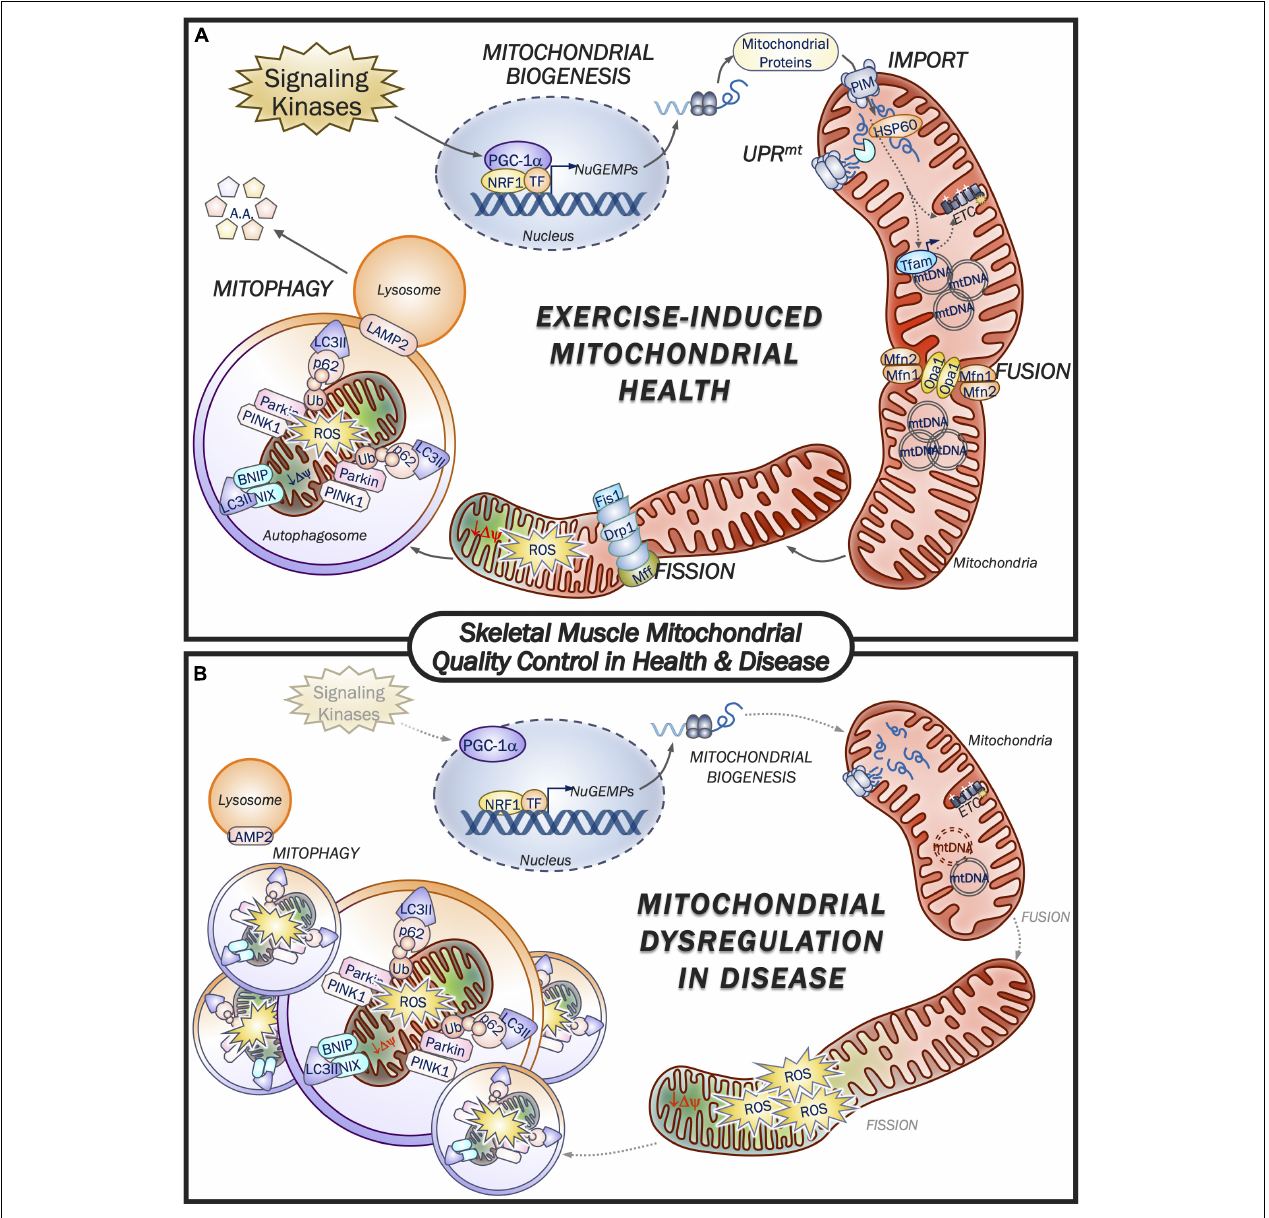
FIGURE 1 | Skeletal muscle mitochondrial quality control in health and disease. (A) Exercise is a potent promotor of mitochondrial health by eliciting increases in mitochondrial quality control machinery. Upstream signaling kinases respond to muscle contractile activity leading to activation of PGC-1 α and augmented transcription of nuclear genes encoding mitochondrial proteins (NuGEMPs). Newly translated mitochondrial-targeted proteins are then transported into the mitochondrion via the protein import machinery (PIM) and are subsequently met by resident chaperones and proteases to facilitate their incorporation within the organelle. The UPRmt is responsible for regulating the expression of mitochondrial chaperones and proteases in the presence of a stress stimulus such as exercise. As mitochondrial volume within the myofiber expands, fusion machinery adjoins neighboring organelles’ inner and outer membranes to facilitate transfer of metabolites, mtDNA, etc. Dysfunctional mitochondrial segments that lose their membrane potential and emit excessive ROS are cleaved from the reticulum by the fission proteins, thereby allowing mitophagy machinery to selectively encapsulate and degrade these non-functioning organelles for delivery to the lysosome. Exercise activates both the biogenesis and mitophagy pathways of MQC to promote the health and viability of the mitochondrial pool within muscle. (B) Mitochondrial dysfunction is a hallmark feature of disease, including cancer, aging and associated mitochondrial disorders. In general, activation of signaling kinases is impaired and reduces the drive for mitochondrial biogenesis from the nucleus, while mtDNA copy number can be reduced or have a high proportion of mutated mtDNA, which can serve to blunt mitochondrial expansion. Reductions in fission and fusion machinery impair mitochondrial morphology and shift the fission:fusion ratio in favor of network fragmentation and organelle ROS production. Further exacerbating the mitochondrial derangements is the impaired mitochondrial removal via reduced mitophagic clearance by the lysosome, thus contributing to the poor morphology and function of the mitochondrial network. As described in the text, exercise can reverse many of the pathways that lead to mitochondrial dysfunction, thereby restoring muscle health.